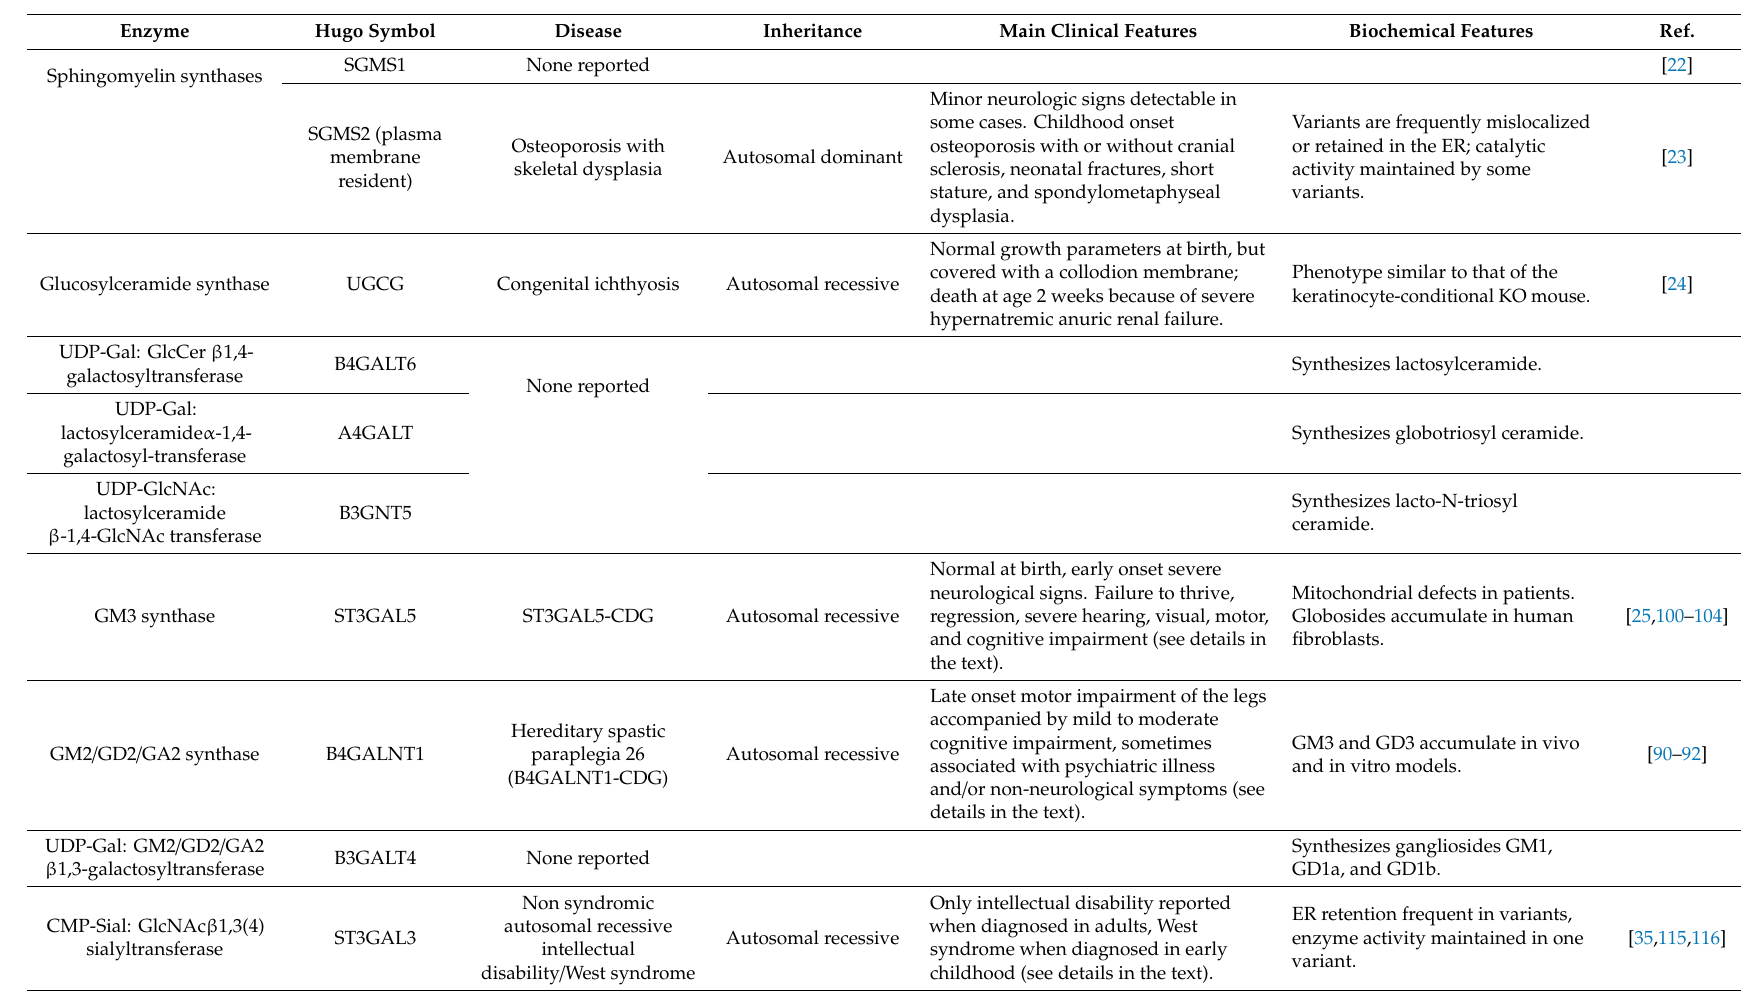
Table 2. Golgi apparatus resident enzyme involved in the biosynthesis of complex sphingolipids. Note that sphingomyelin synthase SGMS2 resides in the plasma